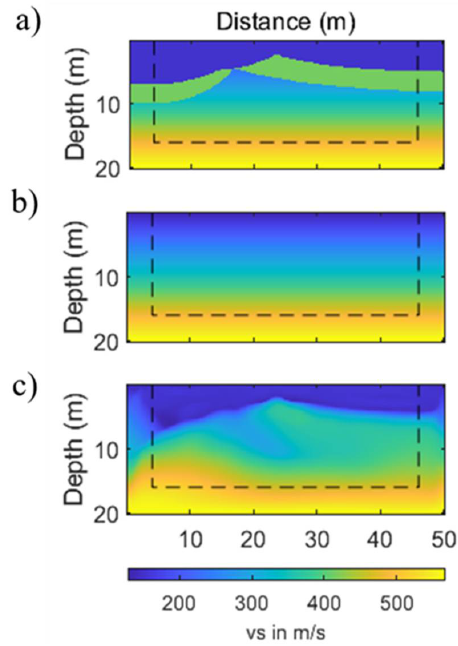
Figure 2. Multi-parameter synthetic example when using a low-frequency source signal: ( a ) the true S- wave velocity model for the calculation of the observed data, ( b ) the initial S- wave velocity model, and ( c ) the inverted S- wave velocity model. The CPML frame is marked by a thin black line.